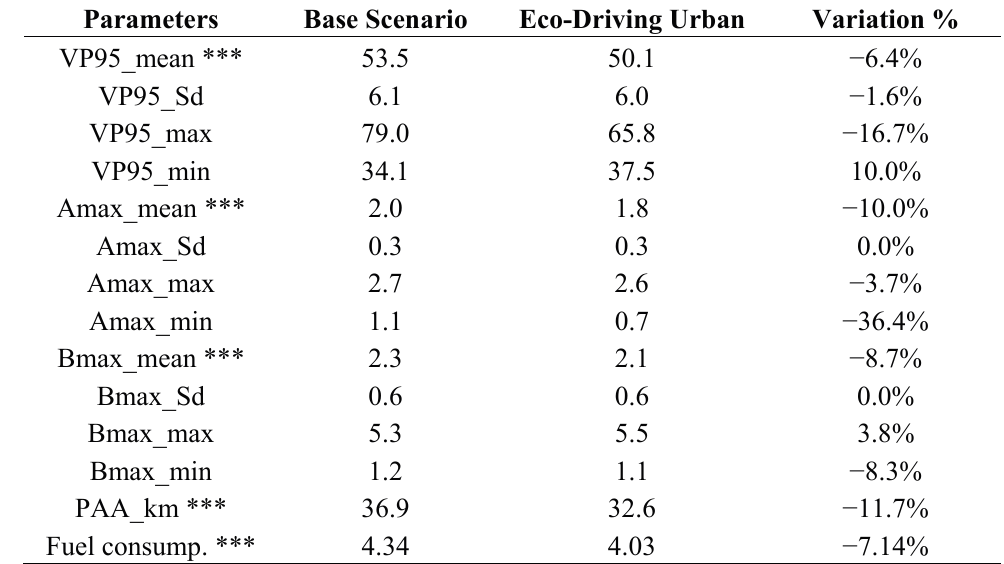
Table 7. Changes in vehicle trajectory variables produced by eco-driving behaviour in urban